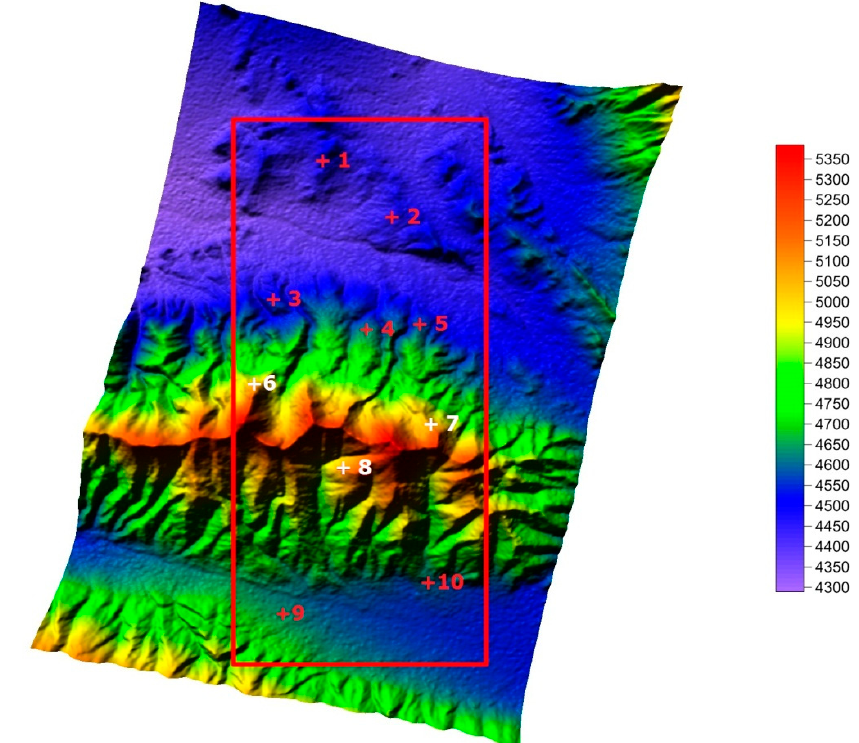
Figure 9. Shuttle Radar Topography mission (SRTM) DEM of the same area (m).